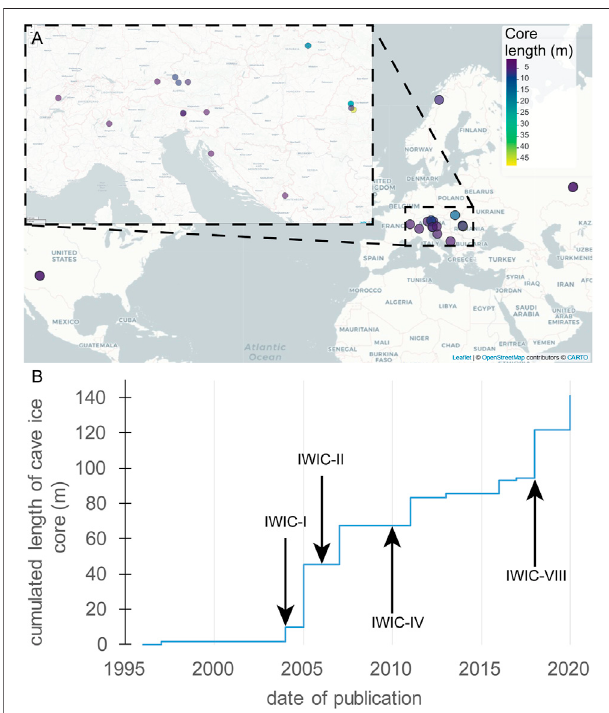
FIGURE 1 | Spatial and temporal distribution of the published cave ice cores. (A) Circlesmarkthelocationofcaveicedepositswithreportedcaveice drilling project. The colour code of the circles shows the total length of the extracted ice cores for each ice cave. The region of Central Europe is enlarged for better visibility. (B) Cumulated length of cave ice cores according to the dateof publication ofthe fi rst scienti fi creference.Datacollection closed by December 31, 2020.